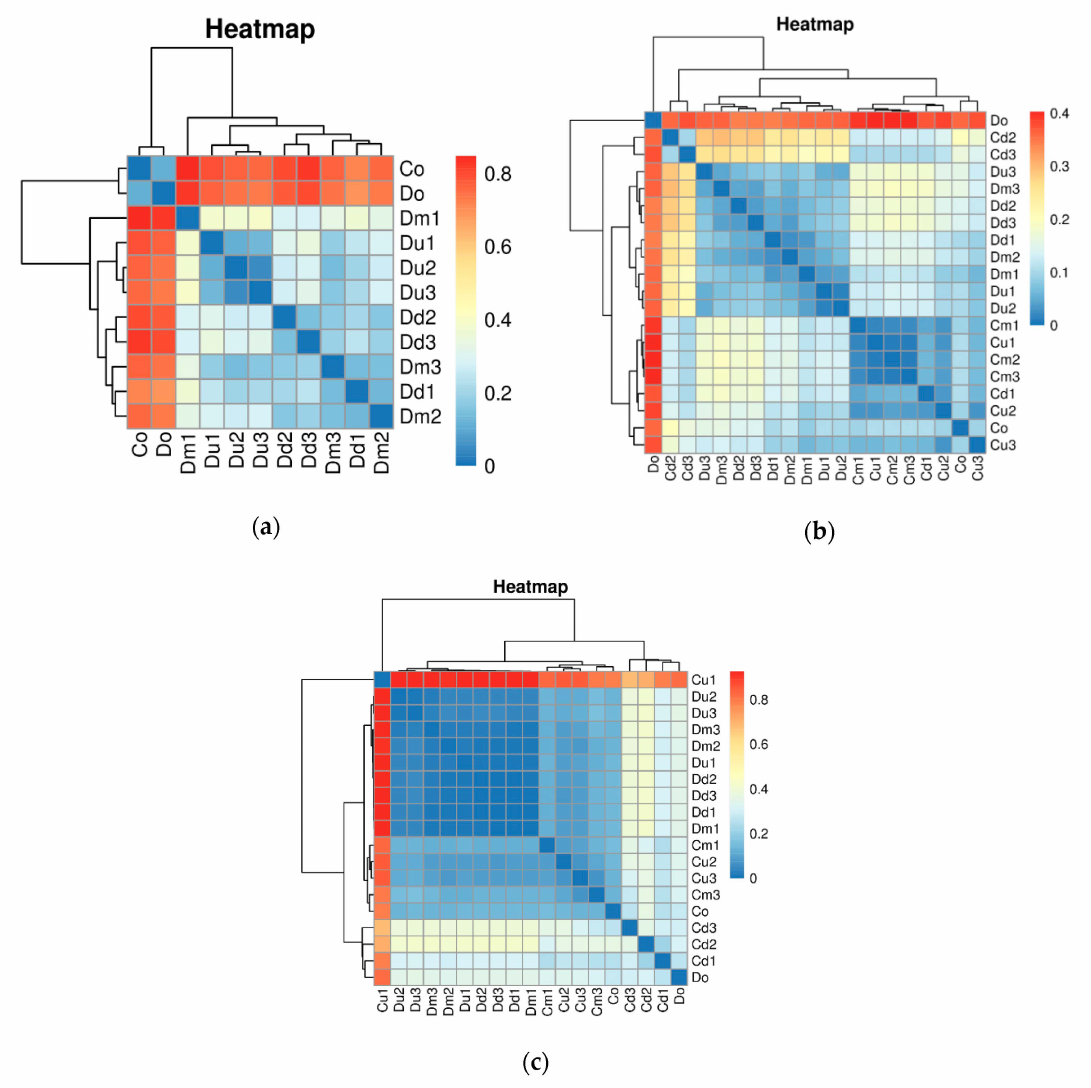
Figure 4. Heat map of weighted UniFrac dissimilarity matrix based on the bacterial community at di ff erent heights and times of ( a ) ammonia-oxidizing archaea (AOA), ( b ) ammonia-oxidizing bacteria (AOB), and ( c ) nitrite-oxidizing bacteria (NOB) in the CFM-DAS